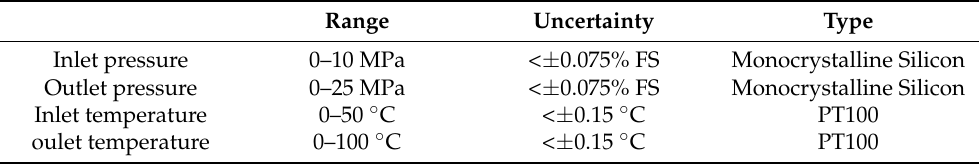
Table 5. The parameters of temperature and pressure sensor.